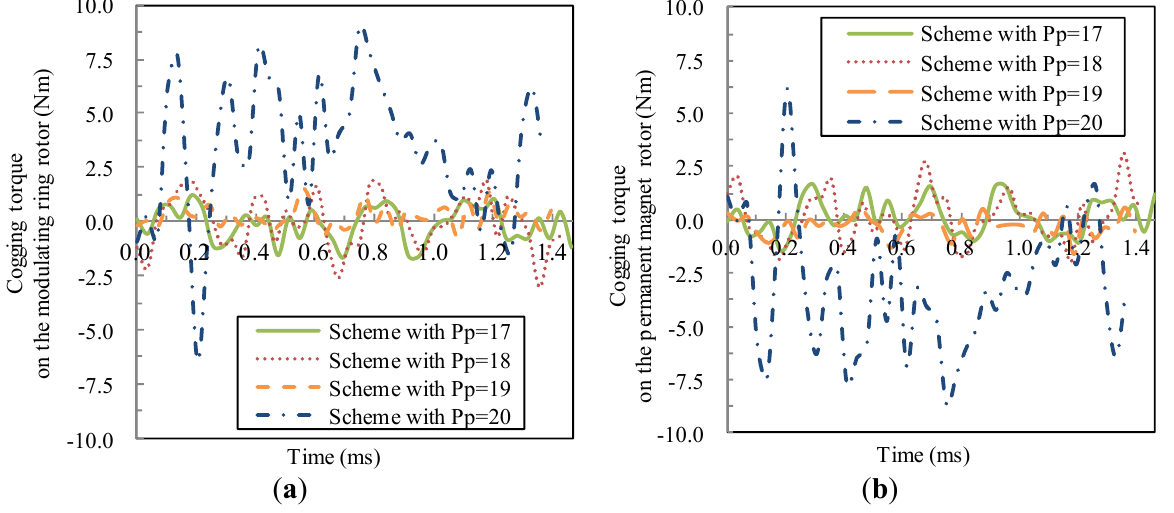
Figure 16. Cogging torque waveforms: ( a ) cogging torque on the modulating ring rotor; and ( b ) cogging torque on the permanent magnet rotor.